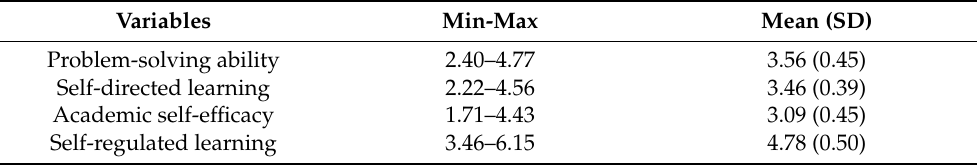
Table 2. Levels of self-directed learning, academic self-efficacy, self-regulated learning, and problem- solving ability ( n =